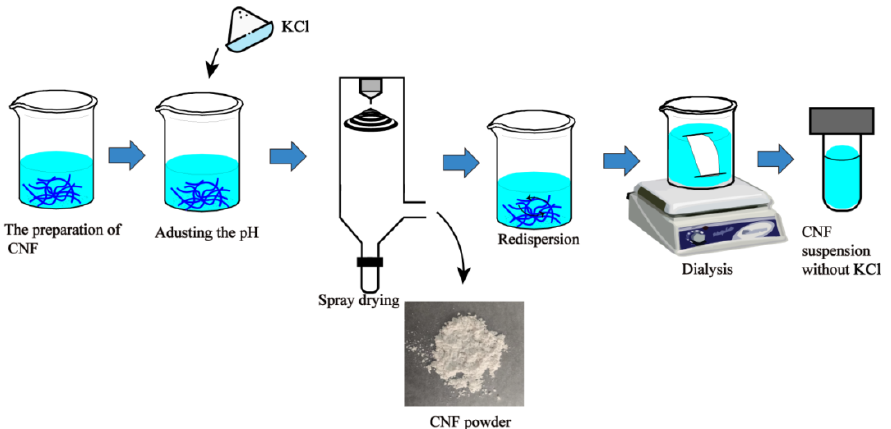
Figure 1. Procedure of preparing cellulose nanofibrils (CNF)-KCl-wash sample.